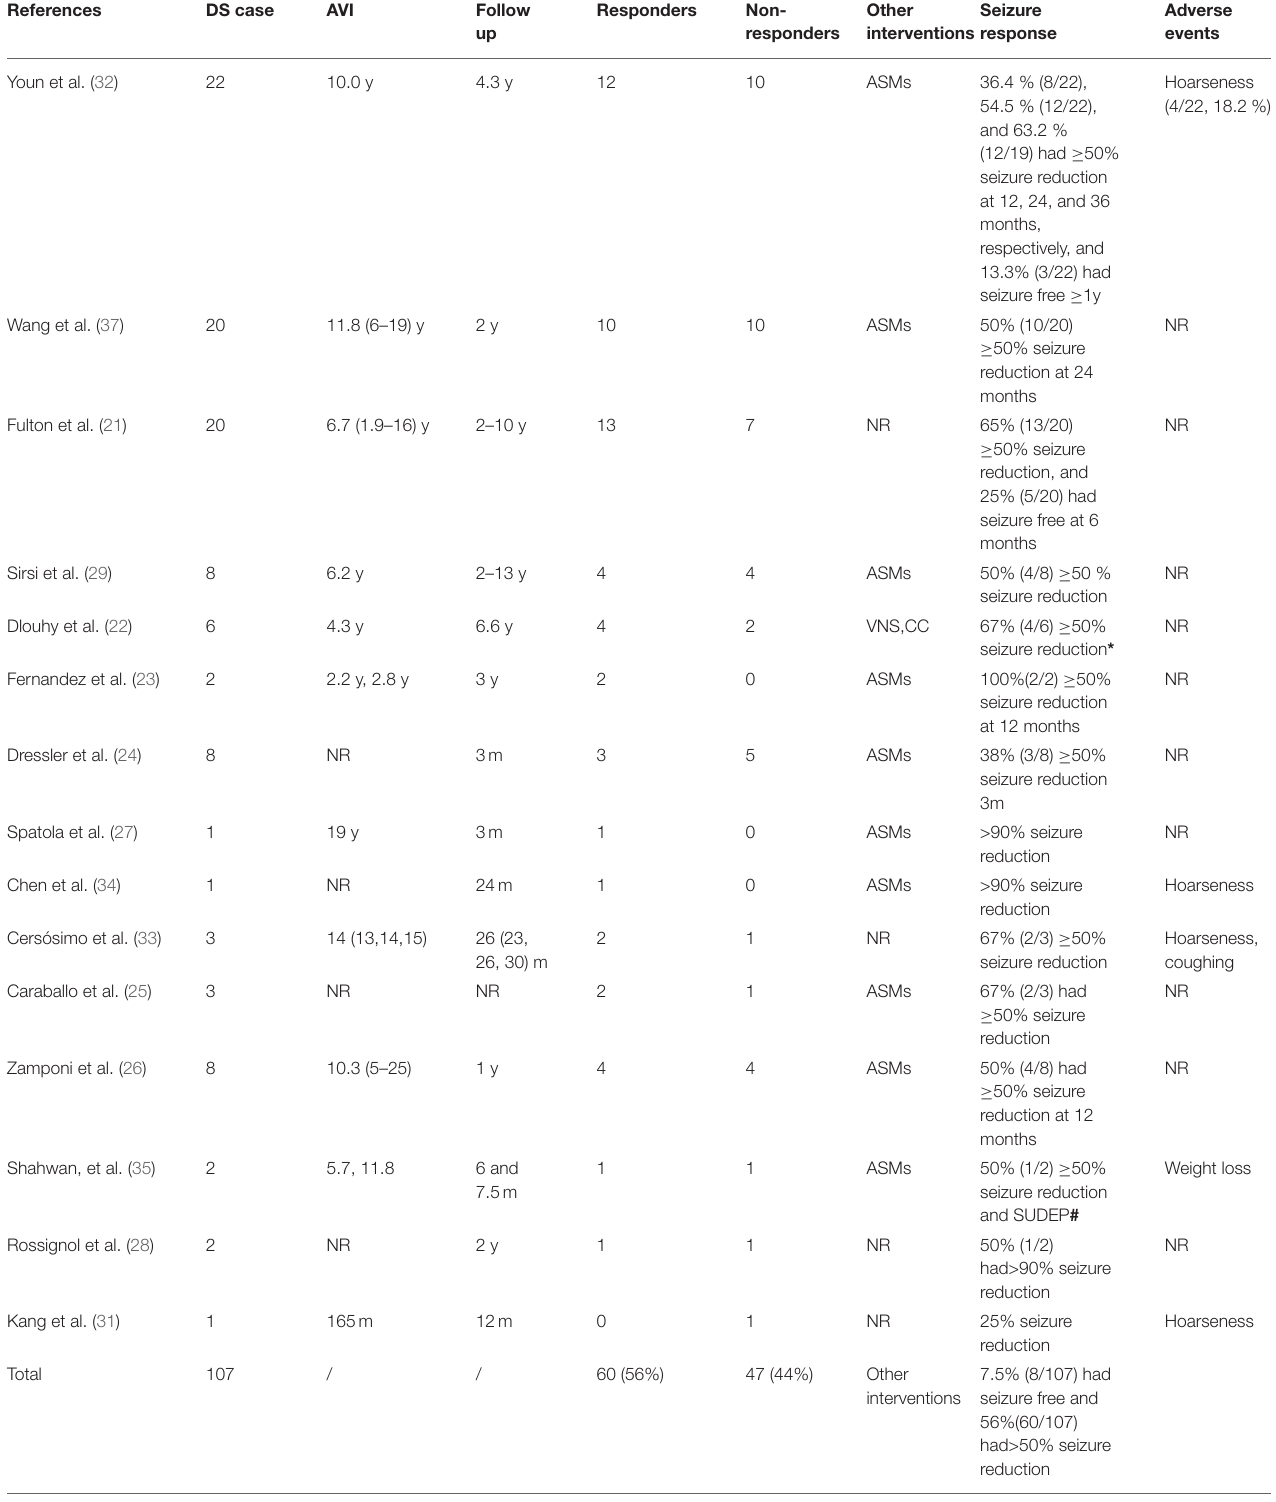
TABLE 1 | Clinical data of DS patients with VNS